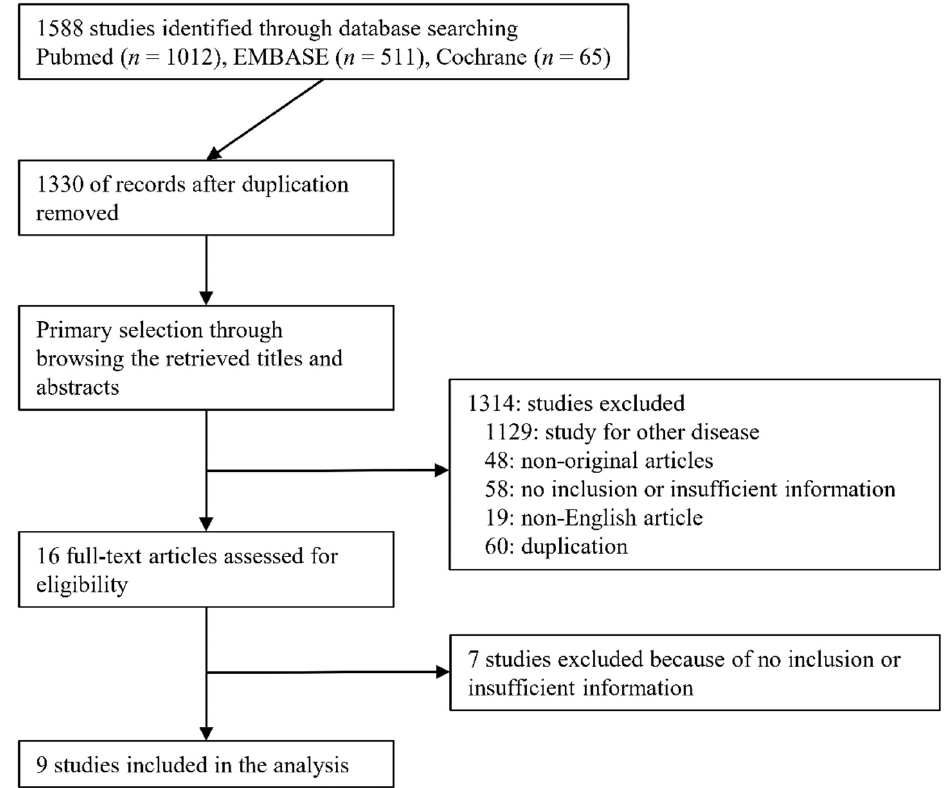
Figure 1. Flow diagram for the identification of eligible studies.